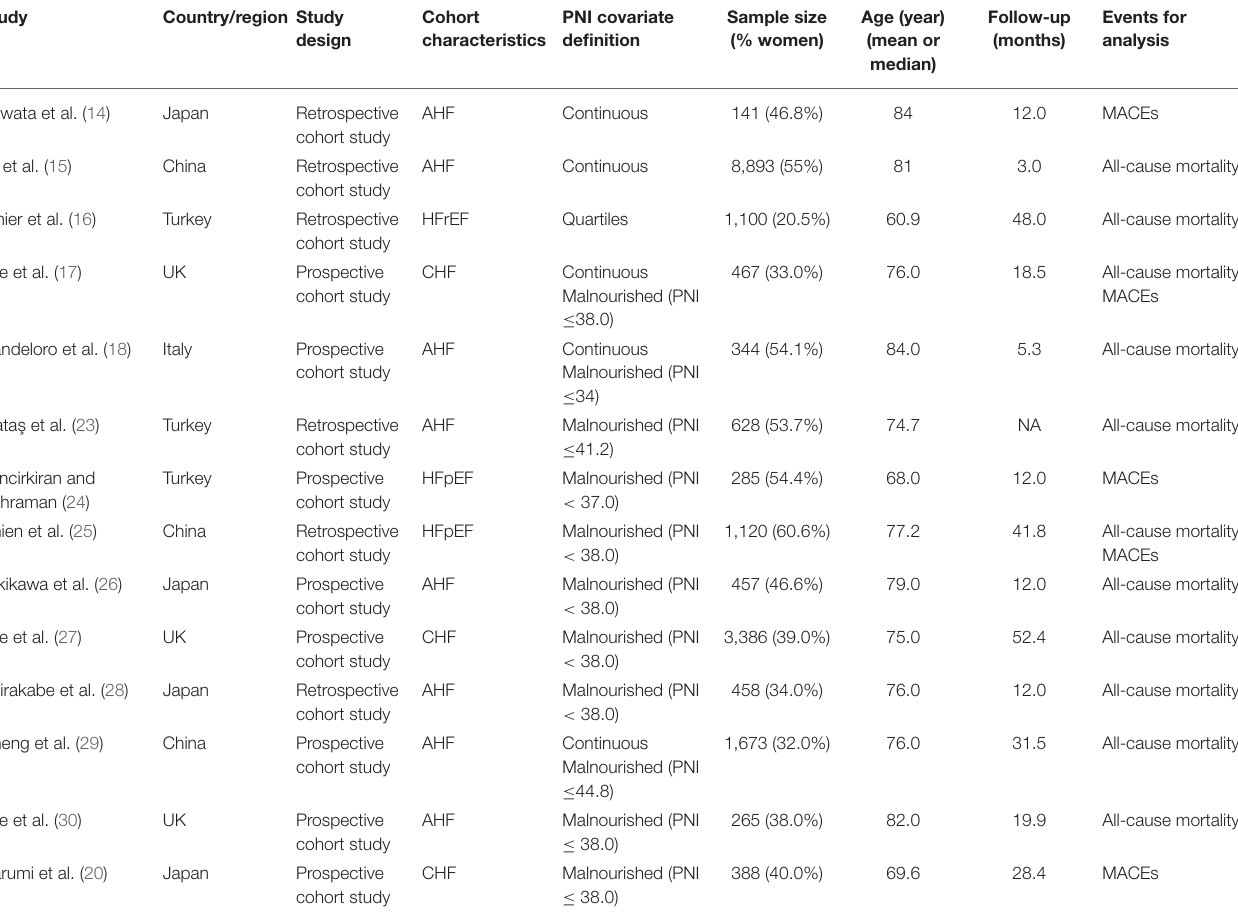
TABLE 1 | Characteristics of studies evaluated the association between prognostic nutritional index (PNI) and the outcomes in patients with heart failure